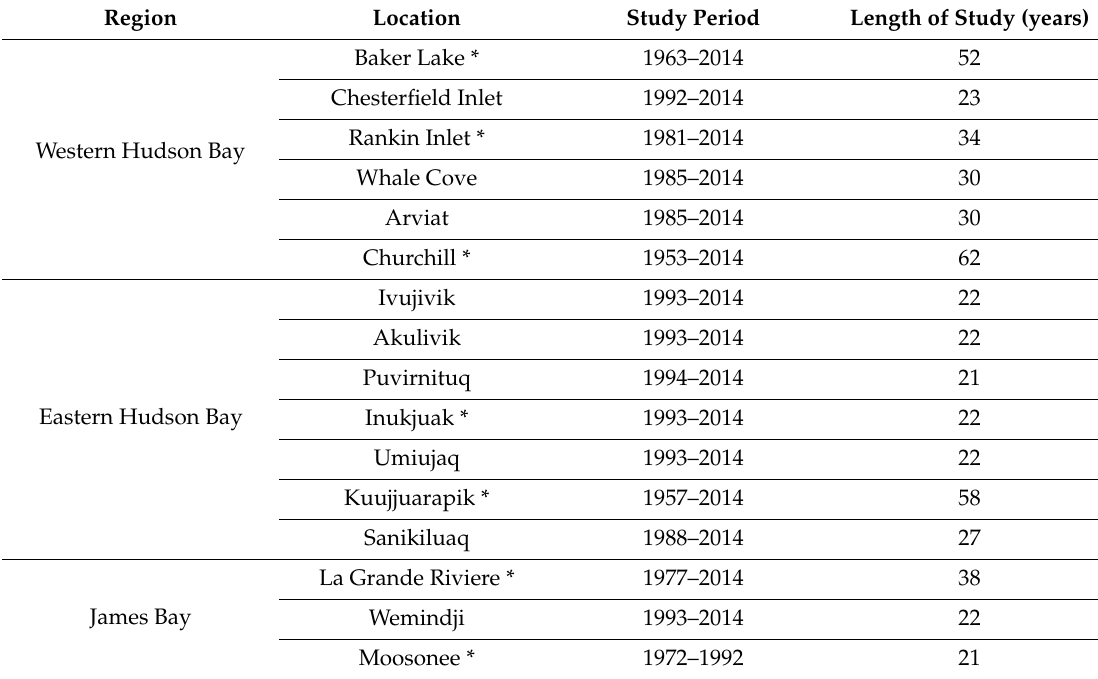
Table 1. The length of study in the selected communities and their regional groupings, with asterisks (*) to indicate 24 h stations.